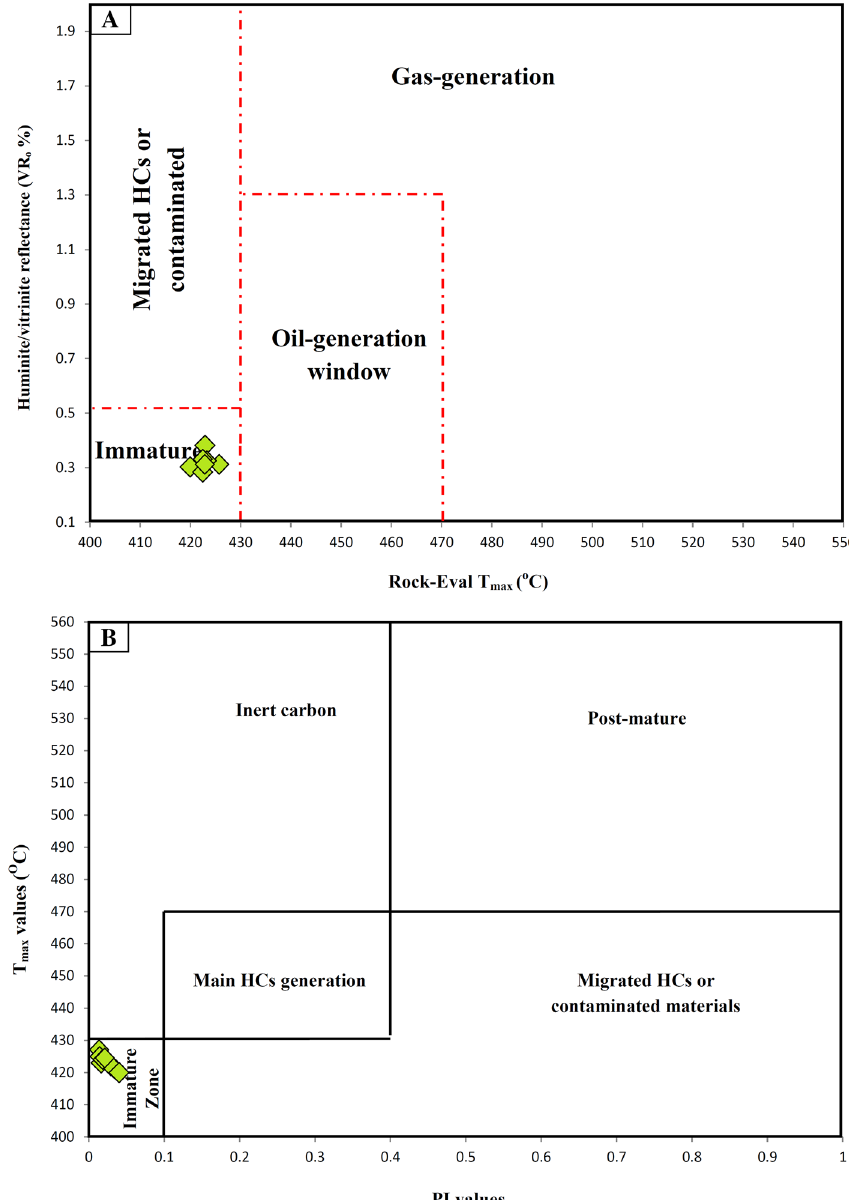
Fig. 14 Geochemical cross- plots of ( A ) pyrolysis T max vs. measured reflectance of huminite/vitrinite reflectance (VR o %) and ( B ) pyrolysis T max vs. production index (PI), show- ing that the analyzed bituminite shale samples from Kapurdi mine are still at an immature stage for oil generation